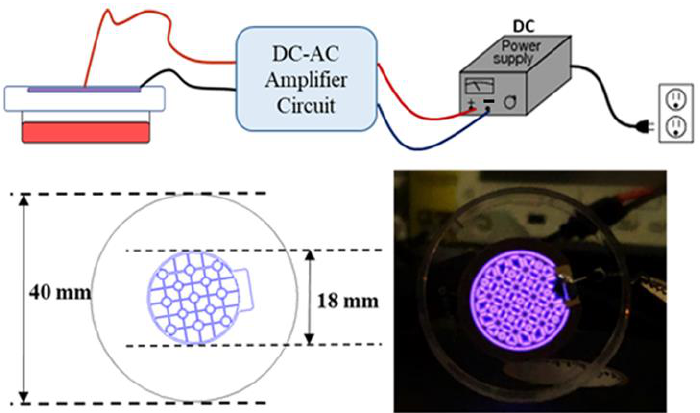
Figure 2. Design of an air-based cold atmospheric-pressure plasma (CAP) device used in this study. A schematic diagram of the dielectric barrier discharge (DBD) type device using air as a gas source for CAP generation is shown in this study. The CAP generated by this device evenly covers the surface of the culture medium.